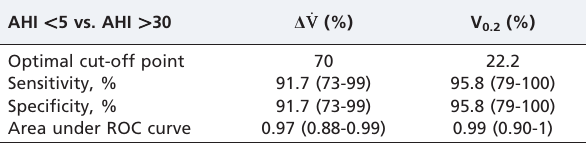
Table 2 - Receiver Operating Characteristic curve analysis for NEP flow drop and expiratory volume at 0.2 s. AHI , 5 vs. AHI .